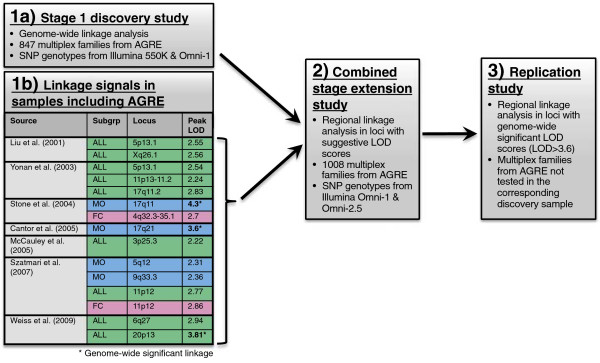
Schematic of three-stage study design for linkage analyses. Linkage analyses were performed using a three-stage approach. (1a) A discovery sample (Stage 1) and (1b) previous linkage results were used to identify loci of suggestive linkage (logarithm of odds (LOD) ≥2.2). (2) These suggestive loci were tested for linkage in an extended sample. (3) For loci achieving genome-wide significant linkage (LOD ≥3.6) in either the discovery, extended, or previously published studies, the non-overlapping subset of families was tested for independent replication of linkage. AGRE, Autism Genetics Resource Exchange; SNP, single nucleotide polymorphism.